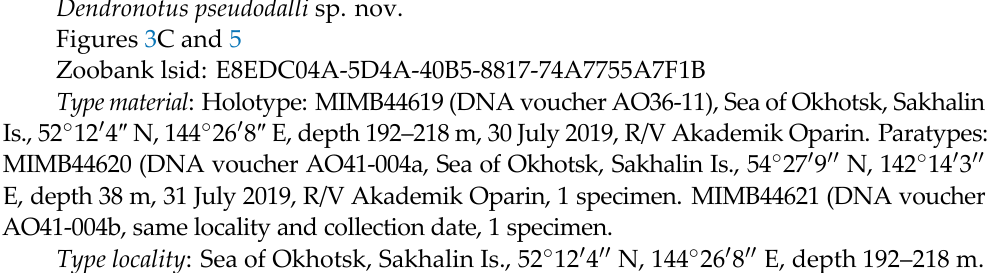
Color (Figure 5A–E): Uniform milky‑white to pale pink. Tips of appendages with lines of opaque white pigment under epidermis. Rhinophores yellow to